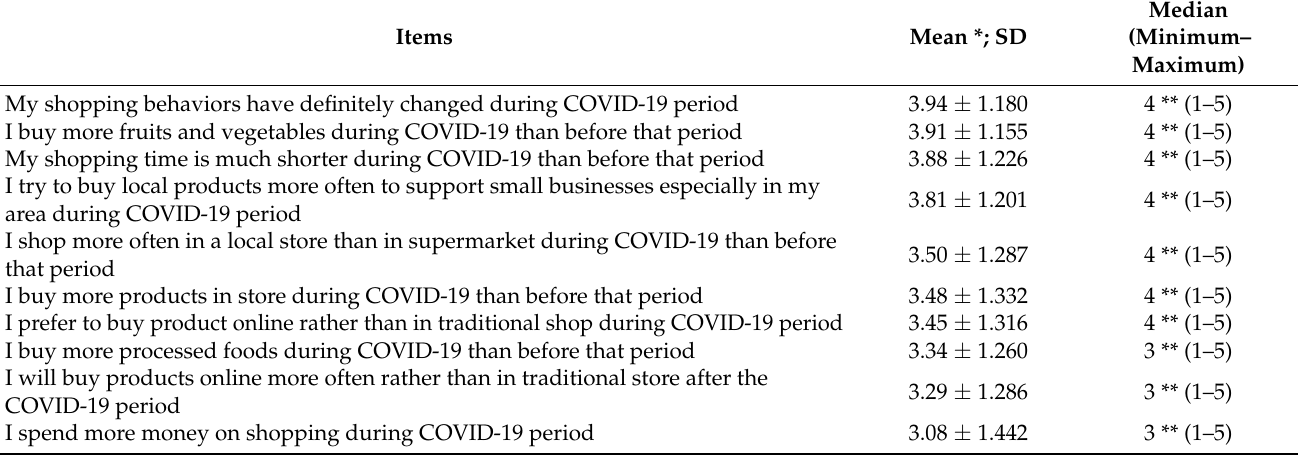
Table 2. Summary of the responses of the survey (N =